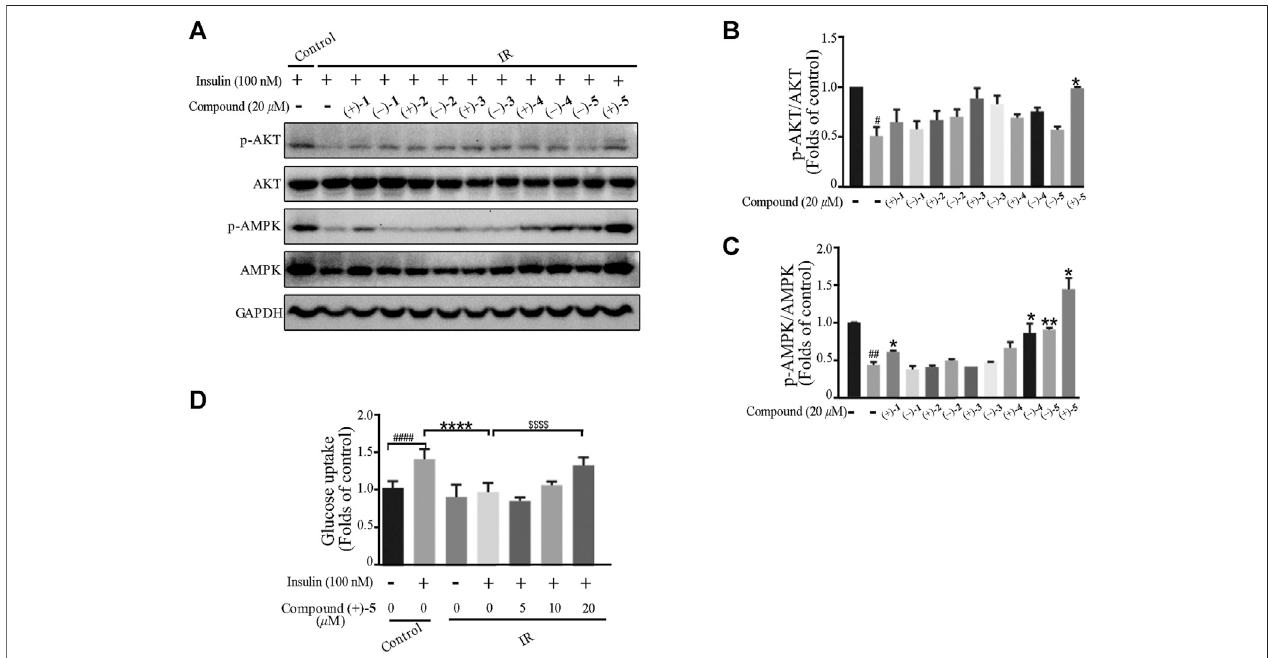
FIGURE 6 | Effects of the compounds on insulin-induced insulin resistance in myotubes. (A – C) Compounds attenuated insulin signal pathway disruption. Bar graphs show the quanti fi cation of the indicated proteins. # p < 0.05 and ## p < 0.01 compared with without insulin treatment control; * p < 0.05 and ** p < 0.01 compared with insulin treatment alone. (D) Compound (+) - 5 improved insulin-stimulated glucose uptake in myotubes. #### p < 0.0001 compared with without insulin-stimulated control; **** p < 0.0001 compared with the insulin treatment group; $$$$ p < 0.0001 compared with insulin treatment